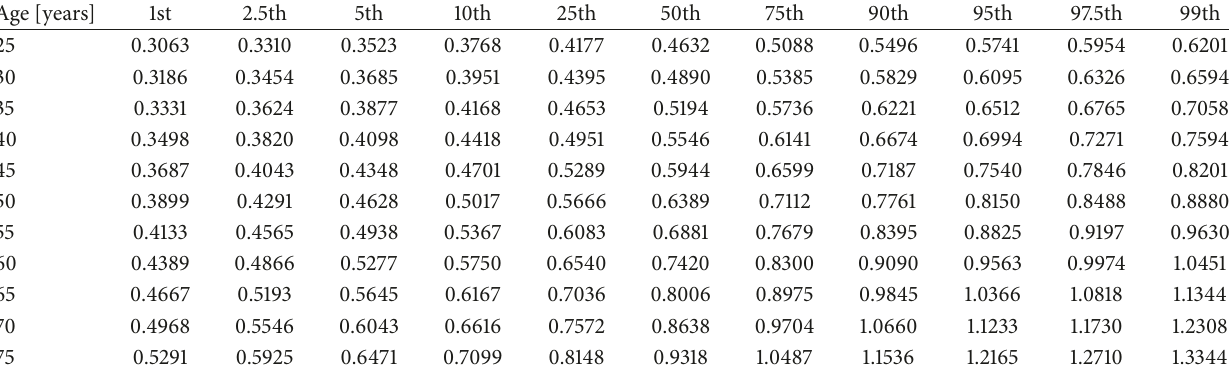
Table 10: Left common carotid intima media thickness [ mm ] percentiles for healthy female